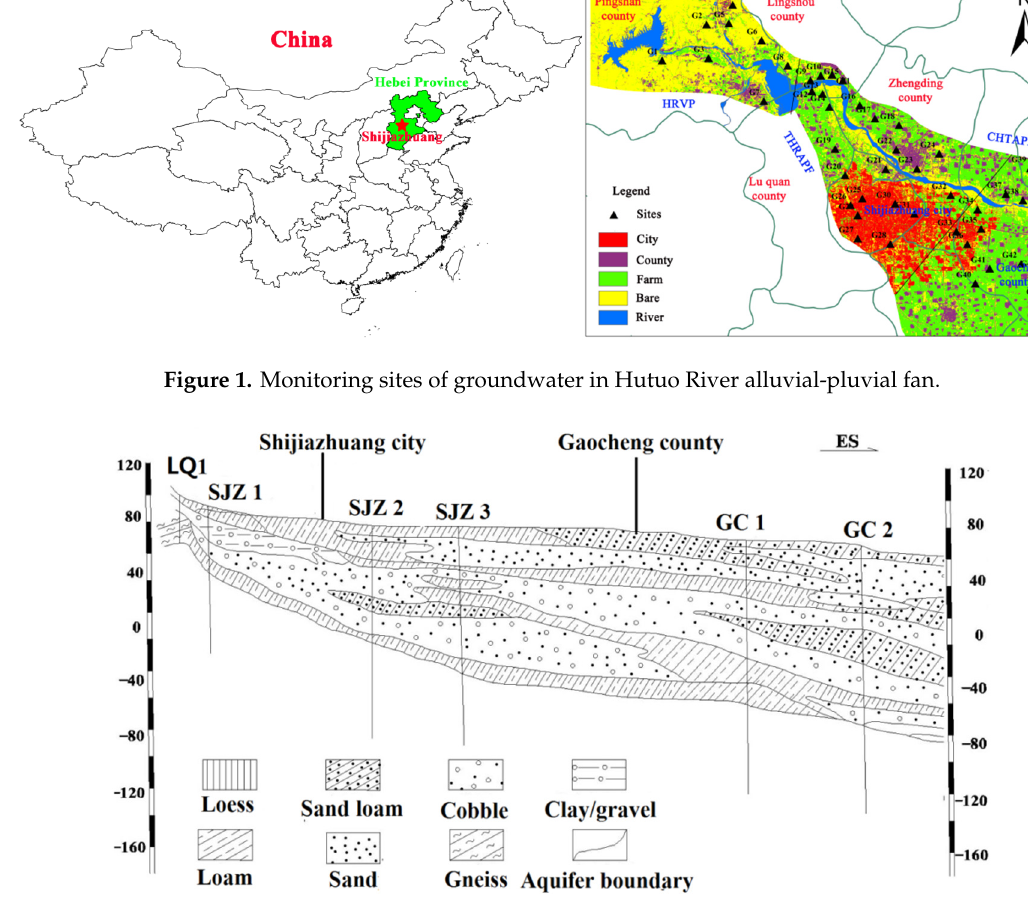
Figure 2. Hydrogeological cross-section of Hutuo River pluvial fan.